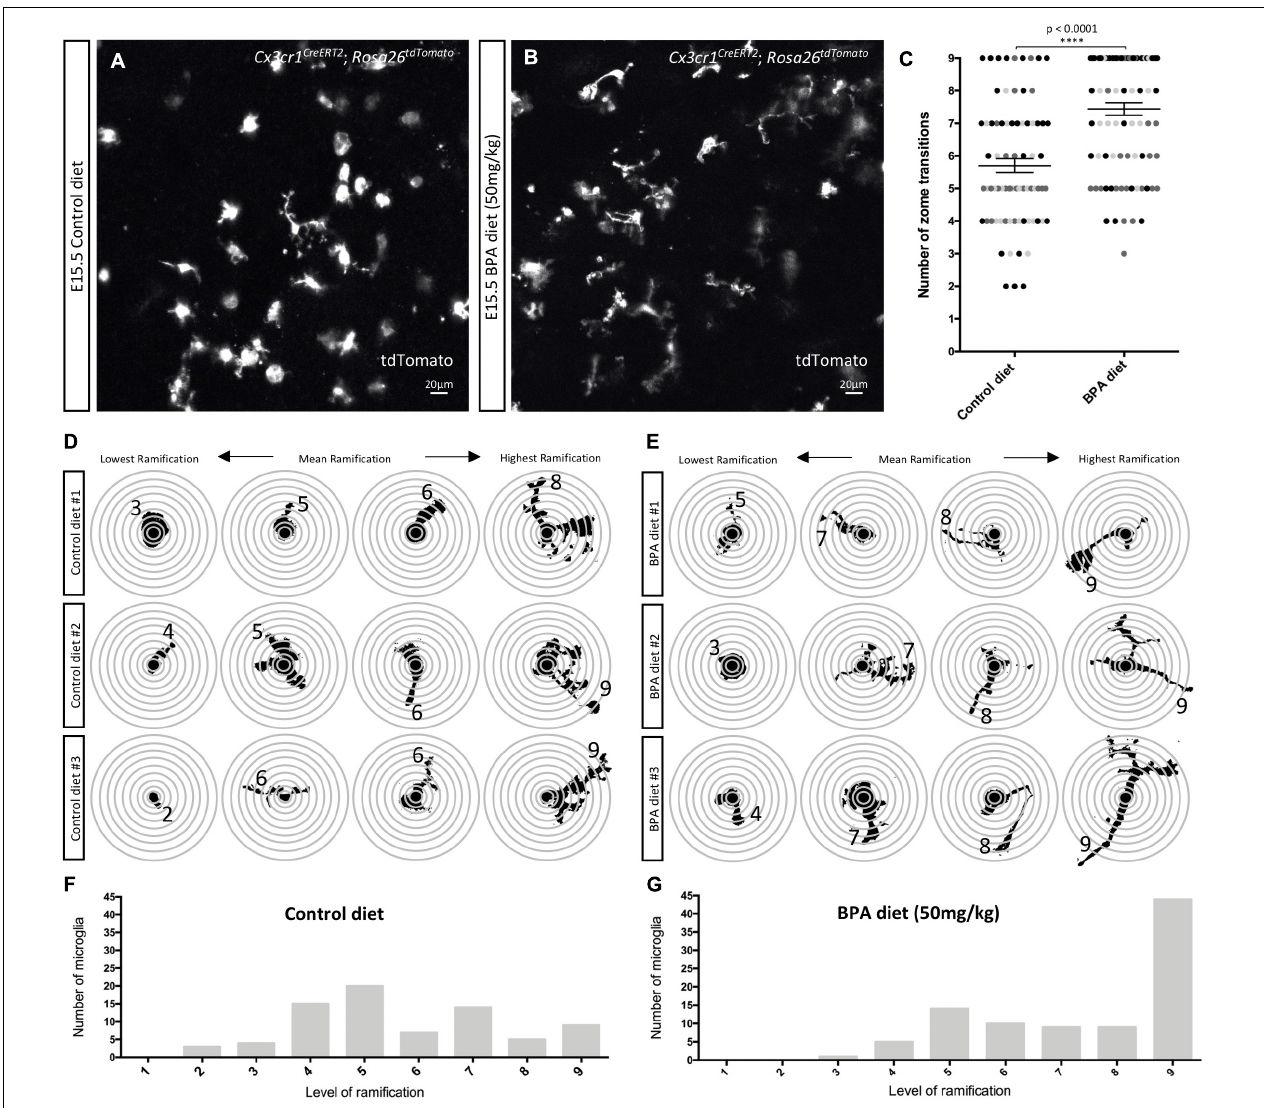
FIGURE 3 | Prenatal BPA exposure enhances microglial ramification in the hypothalamus during embryogenesis. (A,B) Stills taken from live-cell imaging videos of E15.5 control and high dose BPA exposed Cx3cr1 CreERT 2 ; Rosa26 tdTomato double transgenic hypothalamic brain slices, where microglia are labeled with tdTomato. (C) Quantification of the highest level of ramification, displayed as “number of zone transitions,” observed across the entire 5-h live-cell imaging video for each E15.5 control and high dose BPA exposed microglia in Cx3cr1 CreERT 2 ; Rosa26 tdTomato double transgenic hypothalamic brain slices ( n = 3; p < 0.0001). Dots that are the same color represent individual microglia from the same embryo/video, while different colored dots represent microglia from different embryos/videos. (D,E) Visual depiction of SHOLL analysis performed on microglia from each of the control ( D ; n = 3) and high dose BPA exposed ( E ; n = 3) embryos analyzed highlight the lowest, mean, and highest level of ramification observed in each independent embryo. (F,G) Quantification of the total number of microglia with a defined level of ramification (ranging from 1 to 9) documented across 5-h live-cell imaging videos using E15.5 control ( F ; n = 3) or high dose BPA exposed ( G ; n = 3) Cx3cr1 CreERT 2